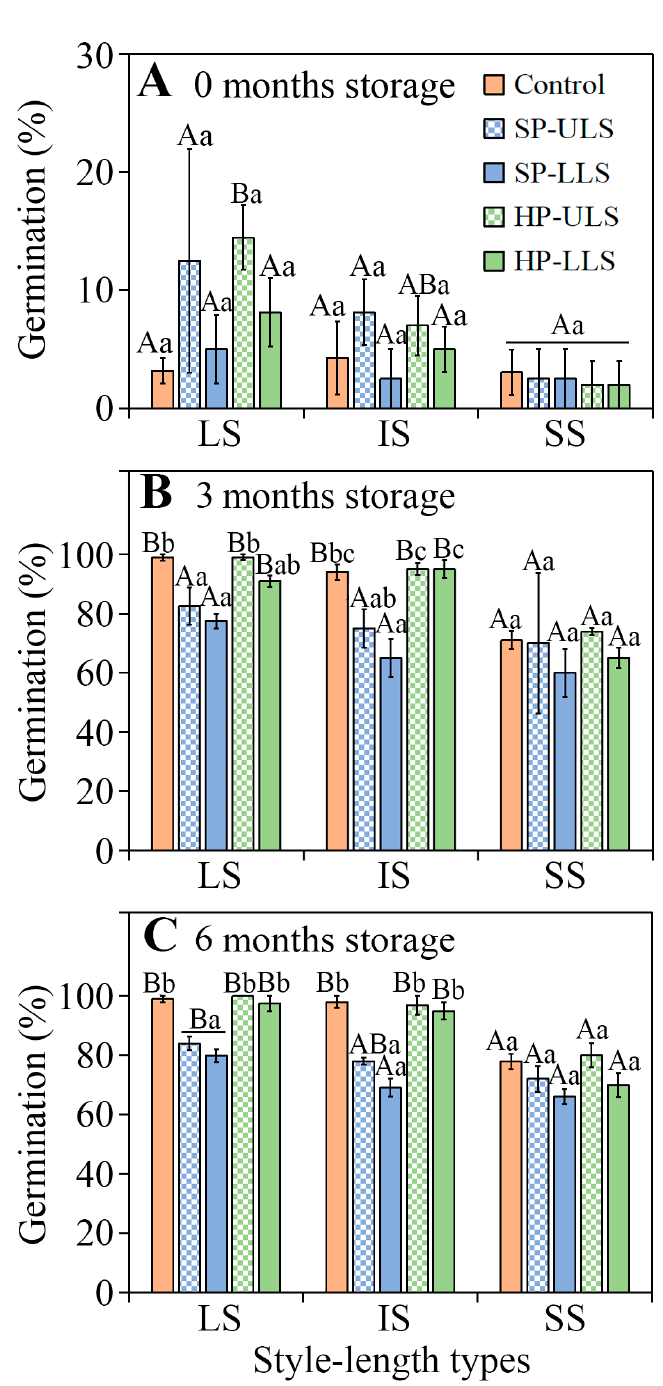
Figure 6. Effect of pollination treatment on final germination percentages of Ixiolirion songaricum seeds from flowers with different style lengths at 15/2 °C in dark following ( A ) 0-months, ( B ) 3-months, and ( C ) 6-months of dry storage at laboratory conditions (mean ± 1 s.e.). LS, seeds from flowers with long style; IS, seeds from flowers with intermediate style; SS, seeds from flowers with short style; Control, natural (open) pollination; SP-ULS, self-pollination with pollen from upper-level stamens; SP-LLS, self-pollination with pollen from lower-level stamens; HP-ULS, pollination between flowers on different plants with pollen from upper-level stamens; HP-LLS, pollination between flowers on different plants with pollen from lower-level stamens. Bars with different uppercase letters (A, B) indicate significant differences among different style lengths in the same treatment of hand pollination and different lowercase letters (a, b, c) significant differences among different treatments of hand pollination at the same style length (Tukey’s HSD, p =